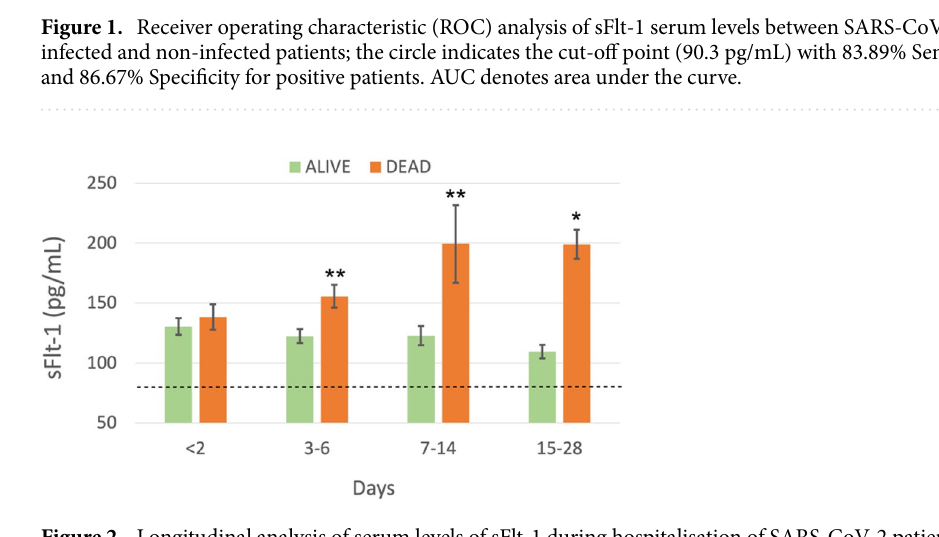
Figure 2. Longitudinal analysis of serum levels of sFlt-1 during hospitalisation of SARS-CoV-2 patients, divided in Alive and Dead according to the outcome of the disease. Patients were monitored for four weeks (less than 2 days, 3–6 days, 7–14 days, 15–28 days from first positive detection of SARS-CoV-2 RNA). The dotted line indicates sFlt-1 level observed in Controls (78.9 ± 2.5 pg/mL); asterisks indicate statistically significant difference: * p < 0.05; ** p <